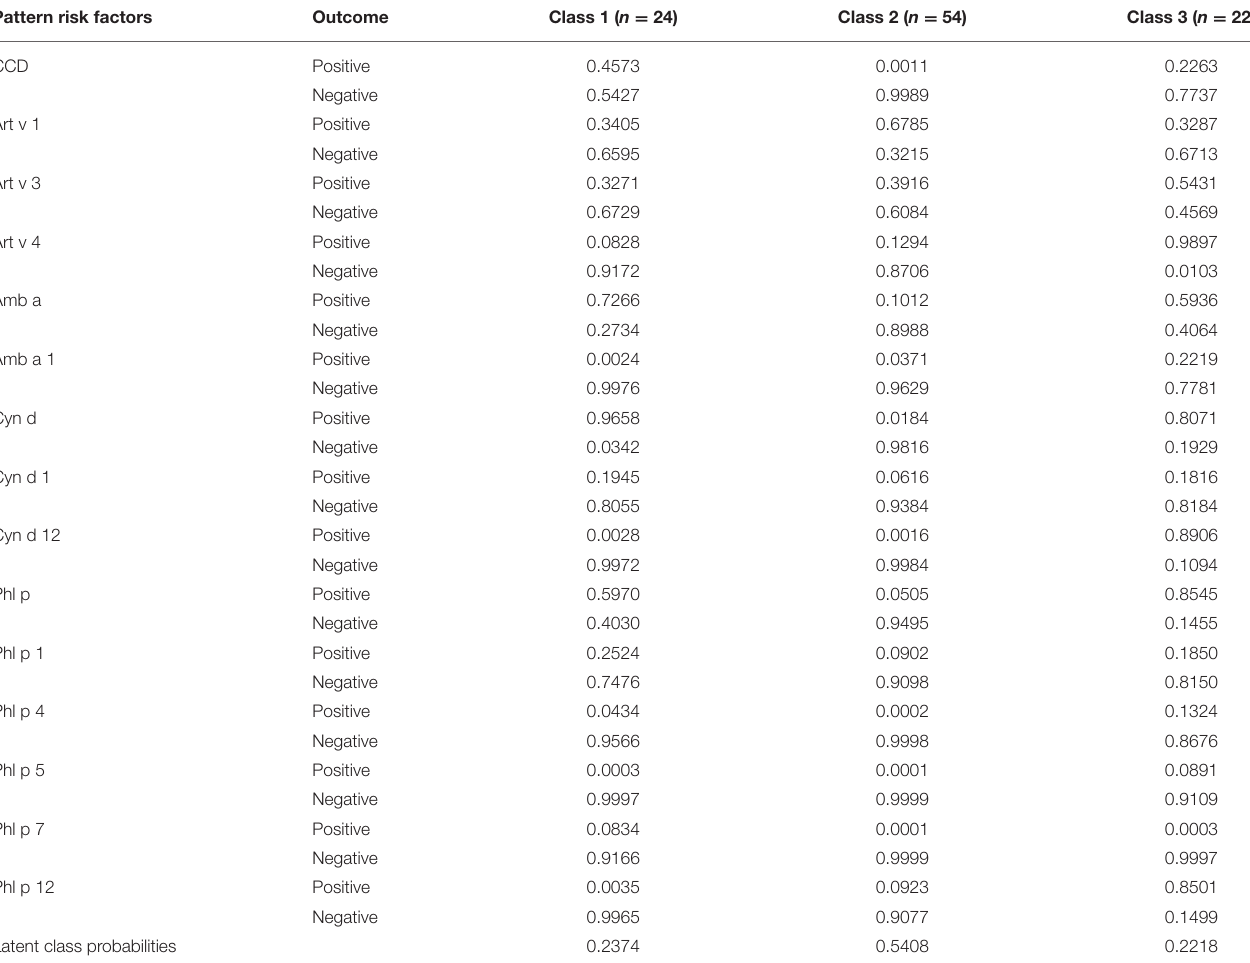
TABLE 2 | Conditional probabilities of pollen sensitization patterns and outcomes in children who sensitized to mugwort. Pattern risk